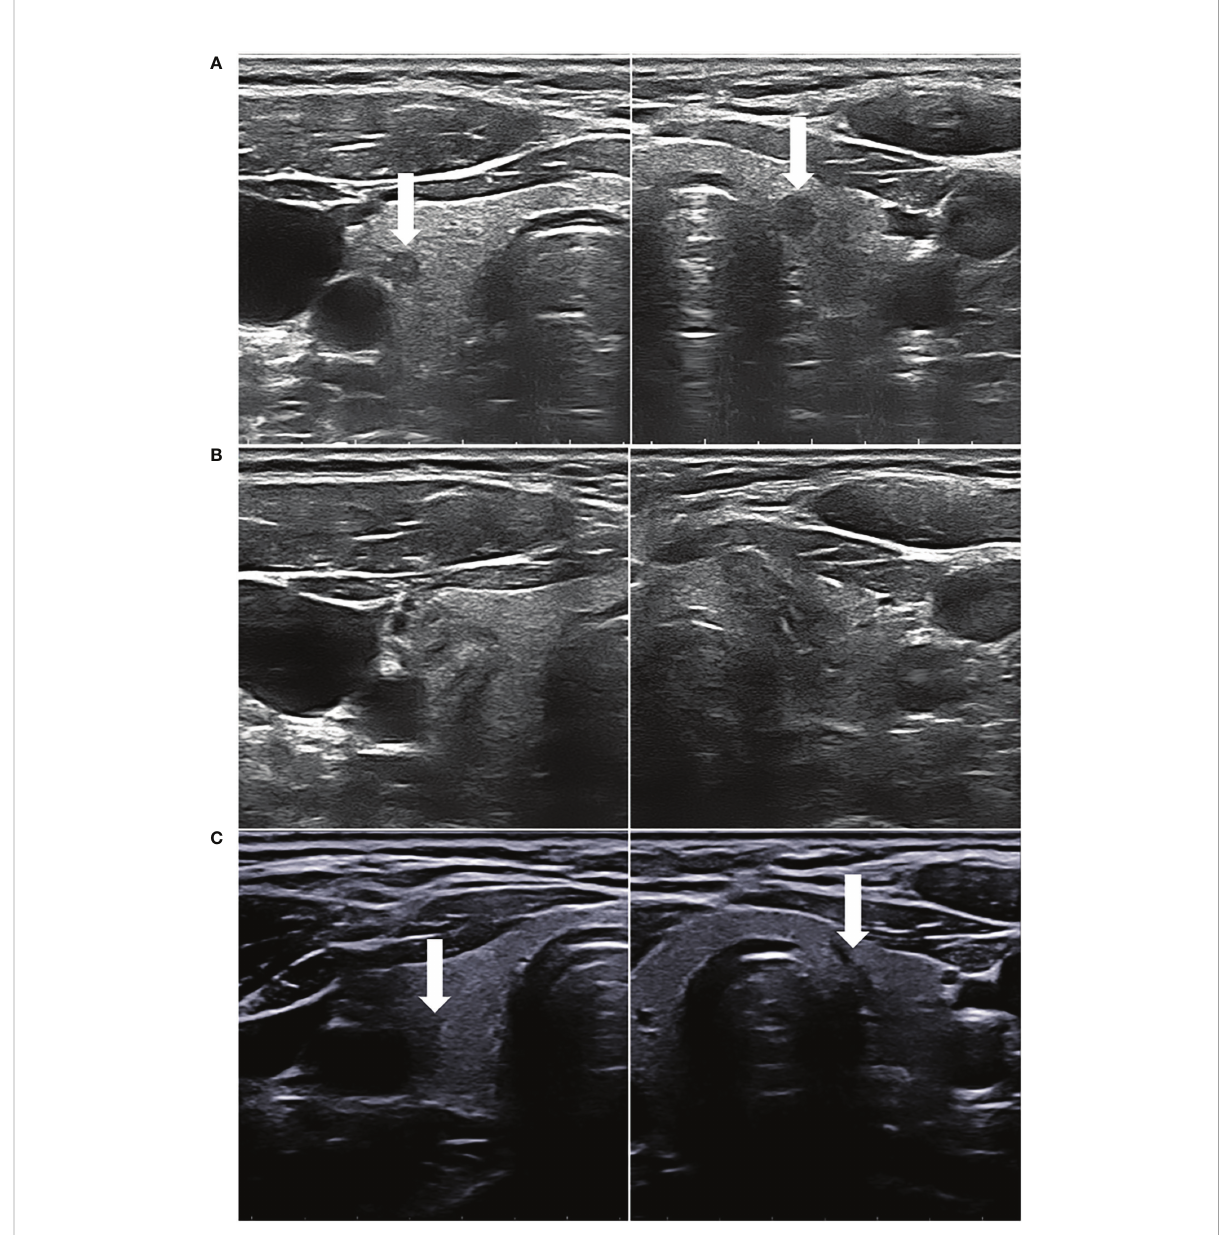
FIGURE 2 (A) A 33-year-old female patient had bilateral hypoechoic lesions (arrowhead), which were con fi rmed as PTMCs by FNAB. (B) After both the PTMCs underwent US-guided PLA, the ablated lesions appeared as well-de fi ned heterogeneous echogenic areas on the grayscale US, with a central hypoechoic ablated needle channel. (C) On the fi nal follow-up, the two ablated lesions were almost completely absorbed, leaving only scar strips